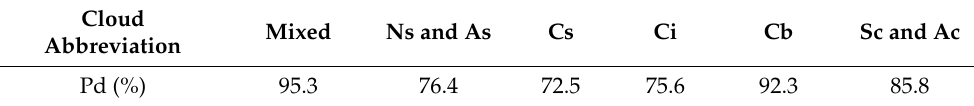
Table 4. The detection rates of different cloud types over the study area in August 2019.